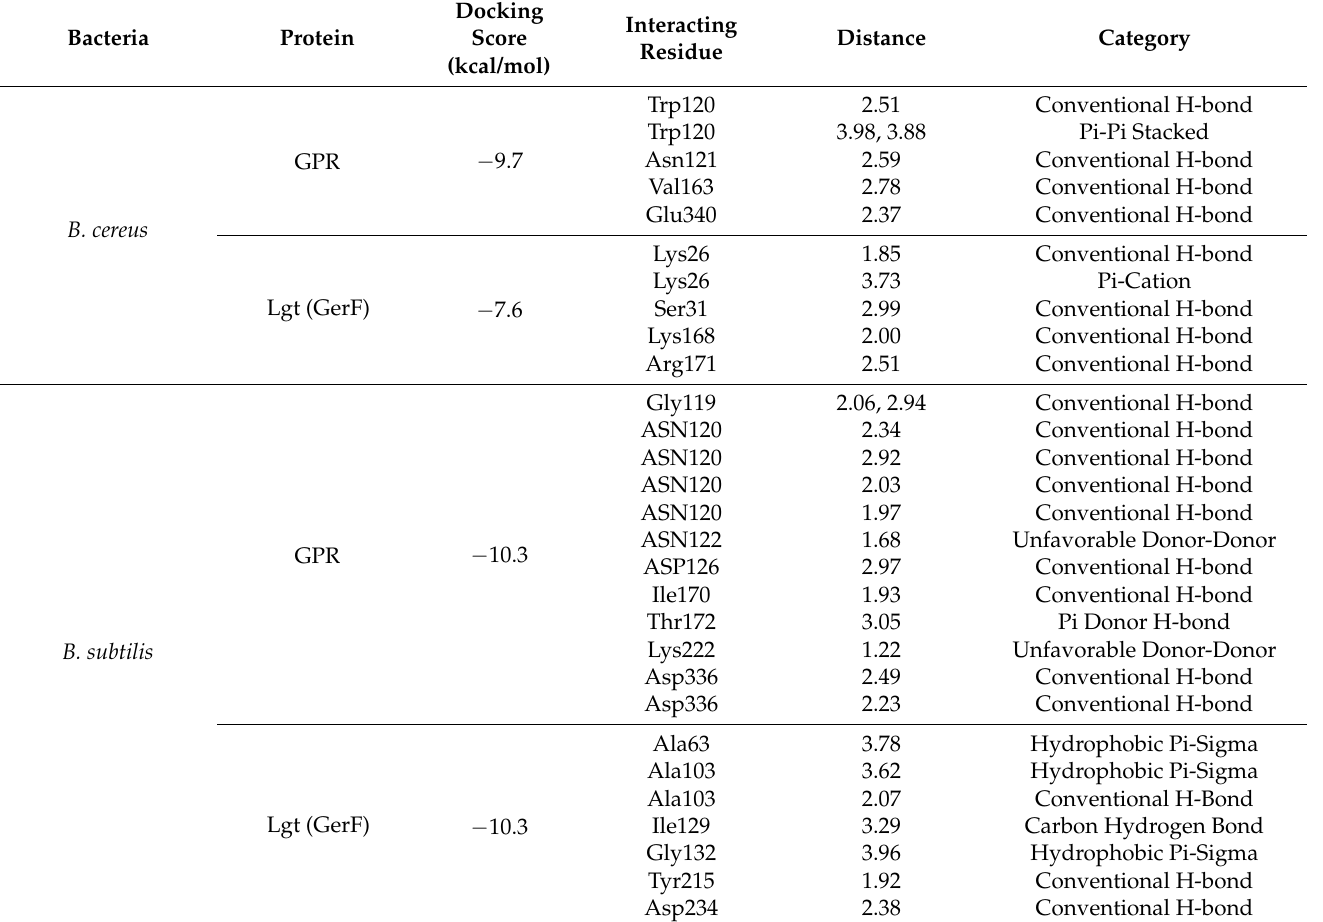
Table 5. Docking analysis of conserved germination proteins. The molecular interaction of TFDG with various genes. The table shows the best binding